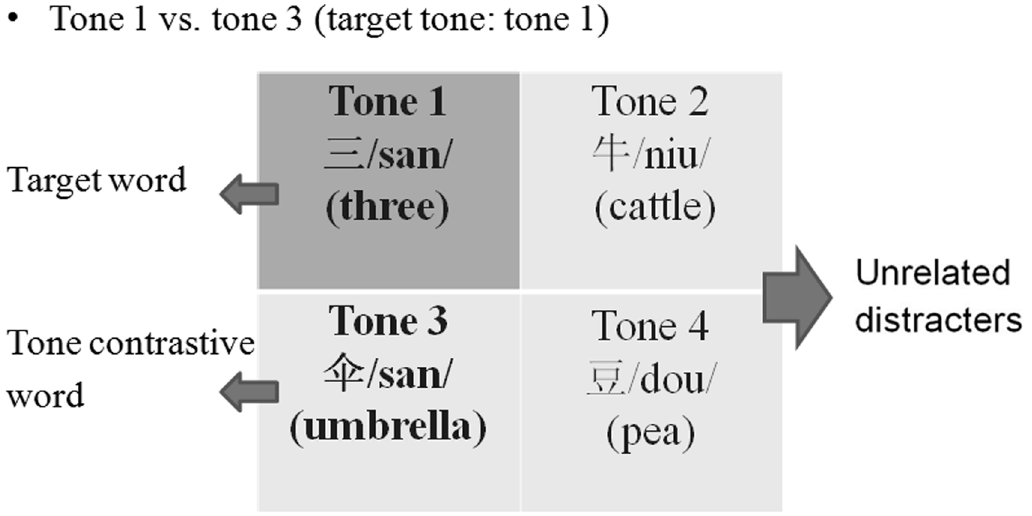
Fig 1. An example test set. It shows that each test set contains four pictures that are located in the four